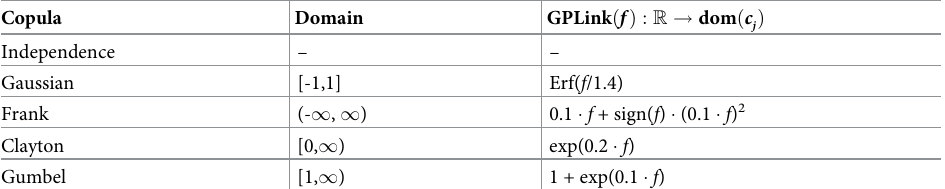
Table 2. Bivariate copula families and their GPLink